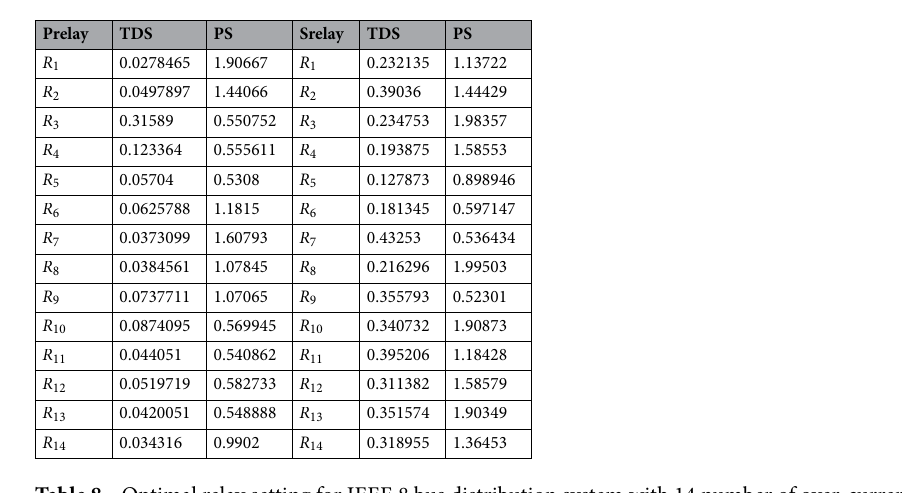
Table 8. Optimal relay setting for IEEE 8 bus distribution system with 14 number of over-current relay.